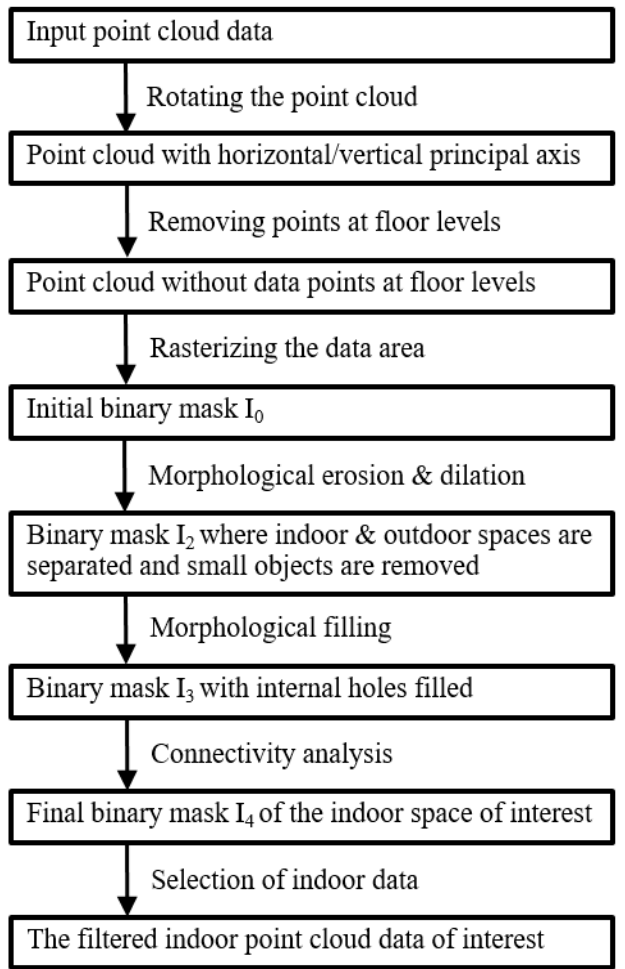
Figure 2. Flowchart of the key steps in the proposed approach.